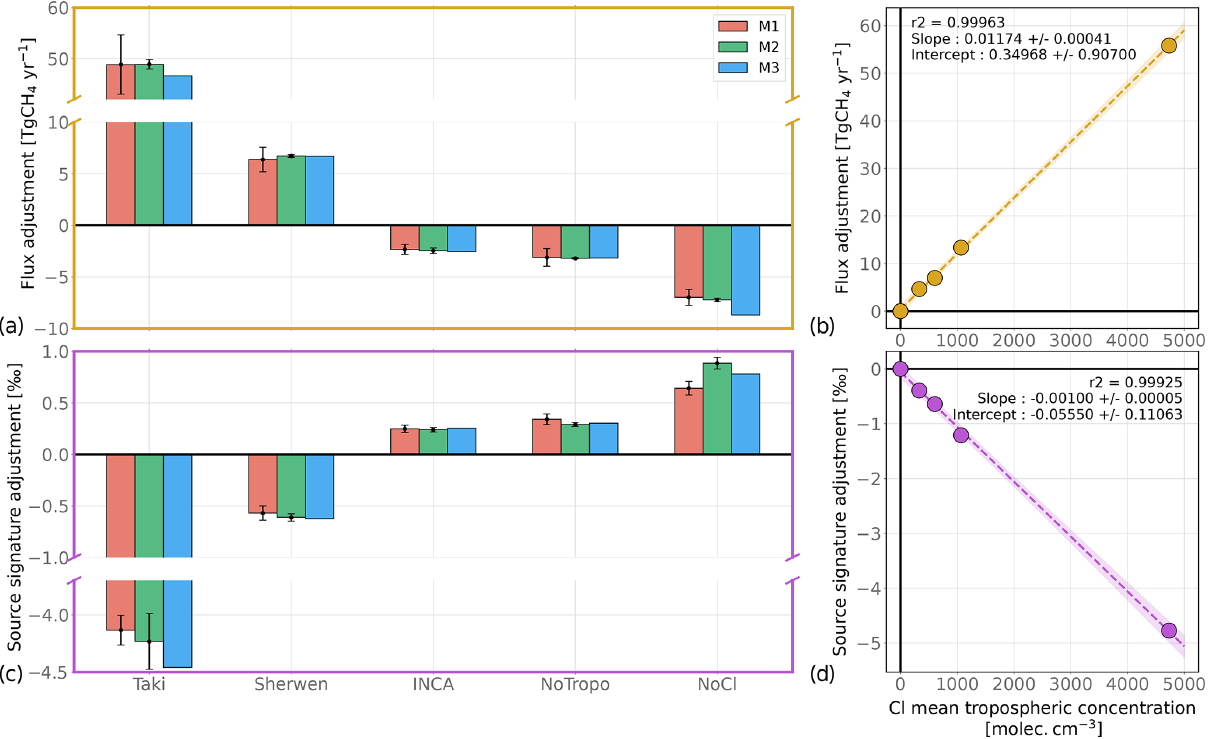
Figure 3. Global CH 4 flux and δ 13 C(CH 4 ) source source signature adjustment due to a change in the prescribed Cl field. Panels (a) and (c) show the adjustments for the global CH 4 flux (a) and δ 13 C(CH 4 ) source source signature (c) with the multiple methods (M1, M2, and M3) presented in Sect. 2.5 and Sects. S1, S2 and S3. Simulations with Cl-Wang are taken as a reference. For M1 and M2, the error bars correspond to the interannual variations (1 standard deviation) of adjustments. Panels (b) and (d) display the linear model derived from the relationship between the adjustments (estimated with M1) and the mean tropospheric concentration of the prescribed Cl fields. For the linear regression only, simulations without the Cl sink (NoCl) are taken as a reference to calculate the